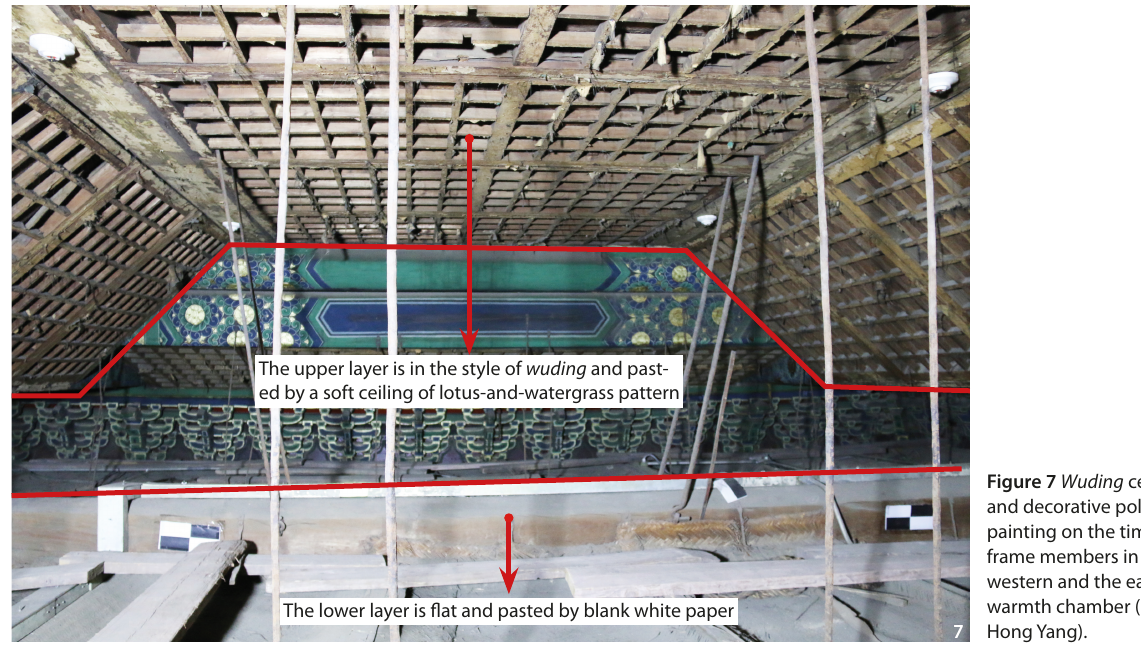
Yang).The lower layer is flat and pasted by blank